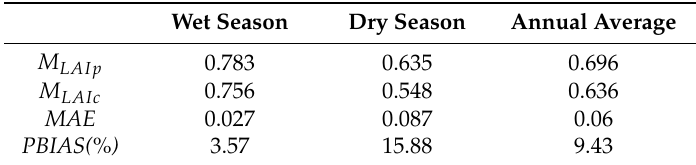
Figure 10. Comparison of average standardized potential LAI ( M LAIp ) and actual LAI ( M LAIc ) from 1994 to 2004. Table 4. Statistic results of comparison between M LAIp and M LAIc from 1994 to 2004.